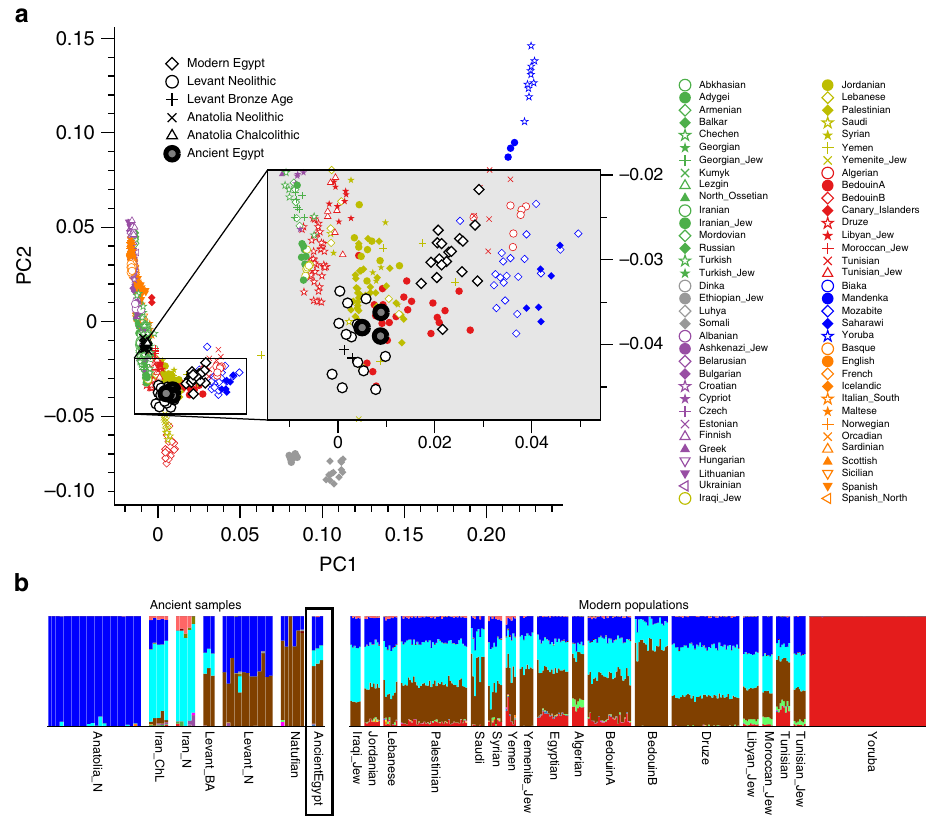
Figure 4 | Principal component analysis and genetic clustering of genome-wide DNA from three ancient Egyptians. ( a ) Principal Component Analysis-based genome-wide SNP data of three ancient Egyptians, 2,367 modern individuals and 294 previously published ancient genomes, ( b ) subset of the full ADMIXTURE analysis (Supplementary Fig.